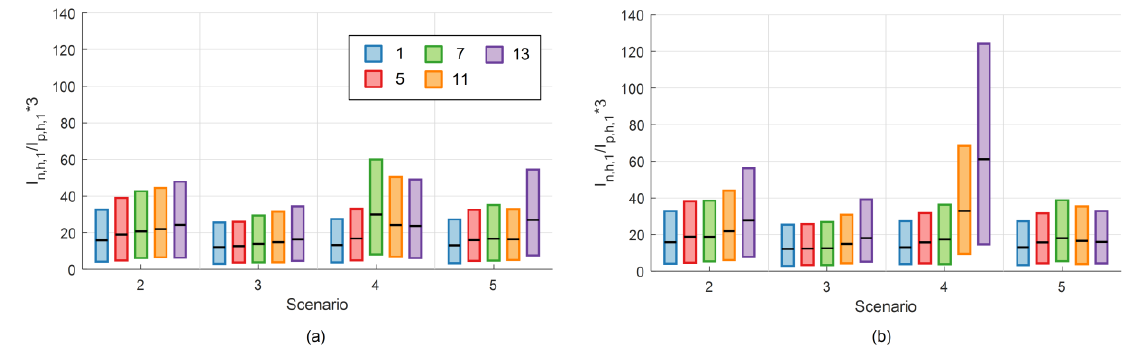
Figure 11. Deviation of non-zero-sequence harmonic currents from the ideal balanced case (0%) at analysis point 1: ( a ) sinusoidal and ( b ) flat-top.